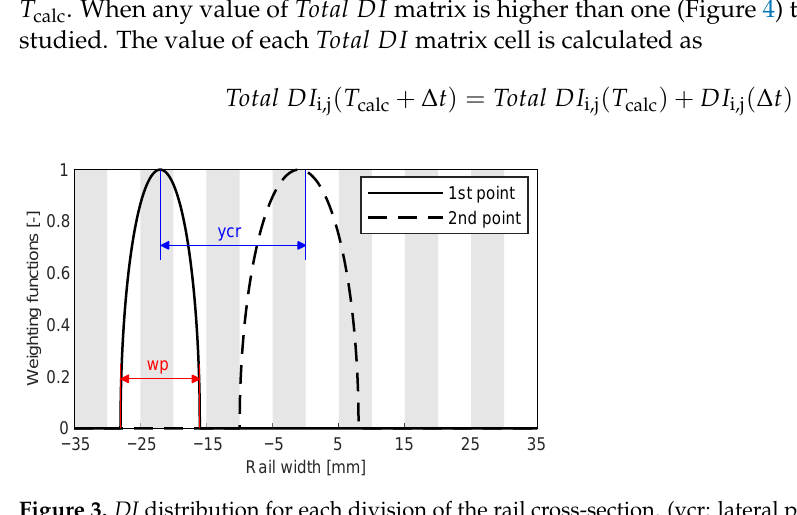
Figure 3. DI distribution for each division of the rail cross-section. (ycr: lateral position of the contact patch center; wp: width of the contact